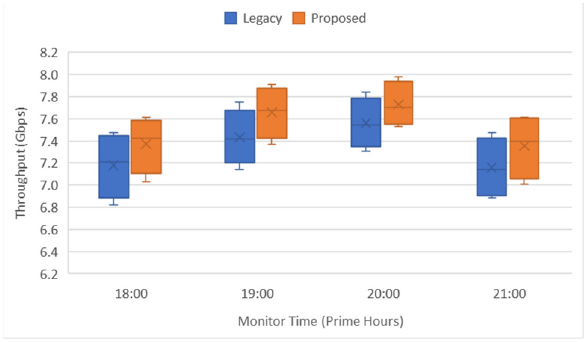
Figure 13. Server leaf switch throughput—All week comparison (output rate).